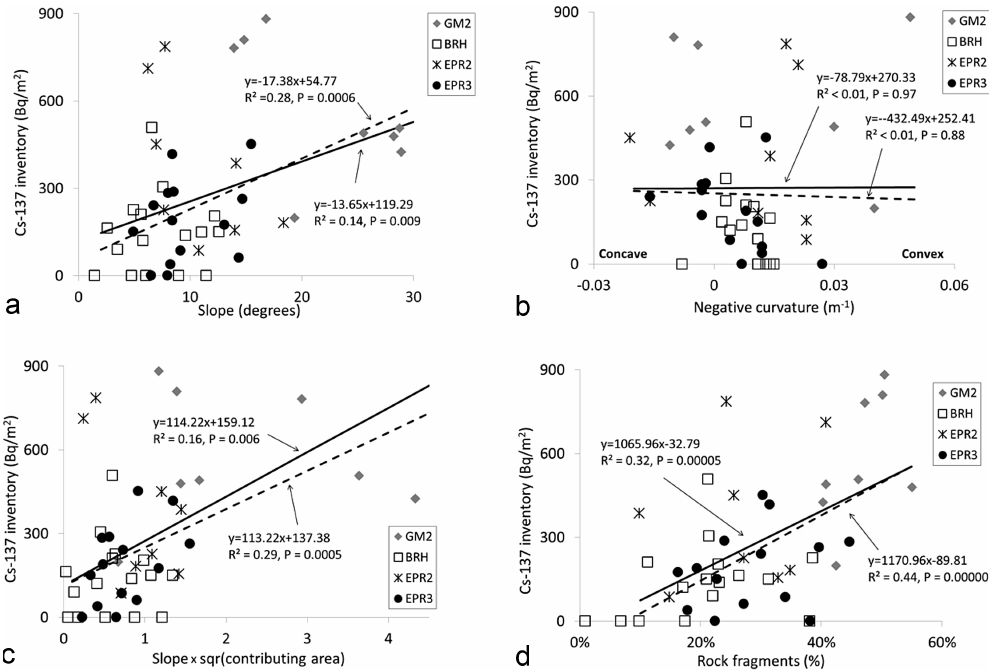
Figure 5. Relationships between total 137 Cs inventories (Bq m − 2 ) per soil pit and slope (a) , curvature (b) , slope × sqrt(contributing area) (c) , and rock fragments in soil R m (d) . Regressions of all data points appear as a black line; regressions of all data points except from site EPR2 appear as a dashed line. The curvature presented is calculated from 1m pixel data; similar nonsignificant regressions were observed also for the 5m pixel curvature